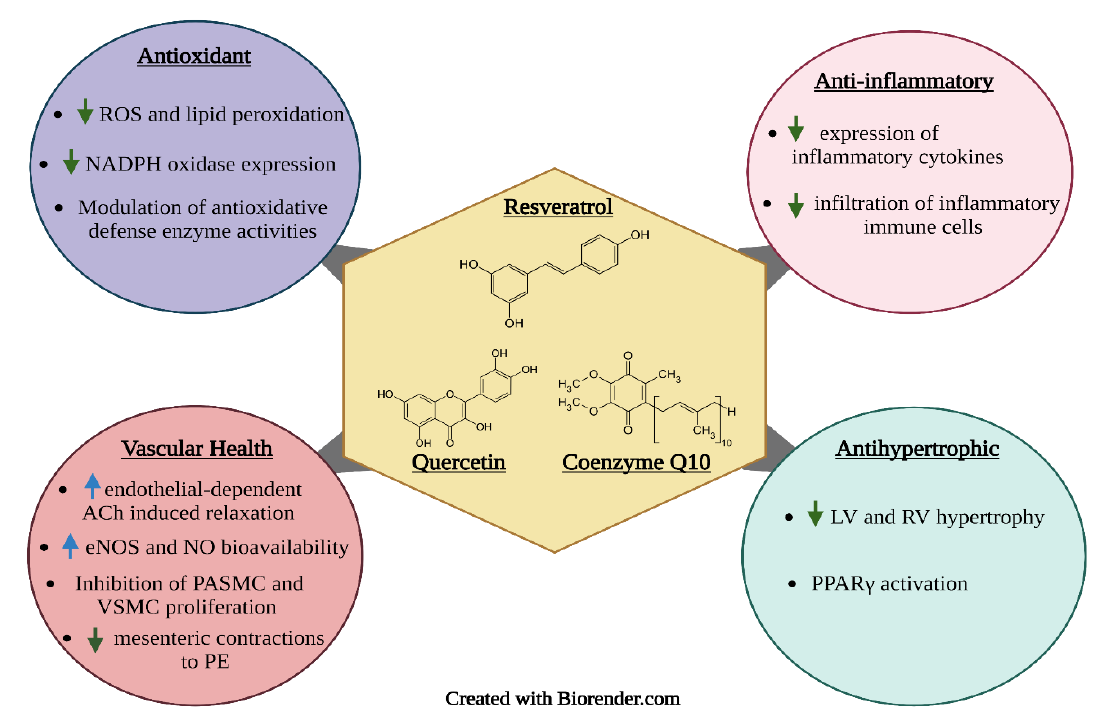
Figure 2. Proposed mechanisms of action of the bioactive phenolic compounds resveratrol, quercetin, and coenzyme Q10. Upward facing arrows indicate an increase in activity, while downward facing arrows indicate a decrease in activity.